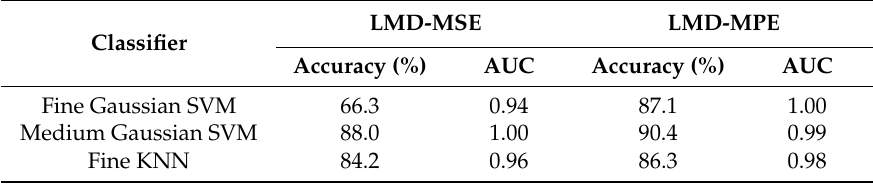
Table 5. Comparison of average of classifiers on REB data Case